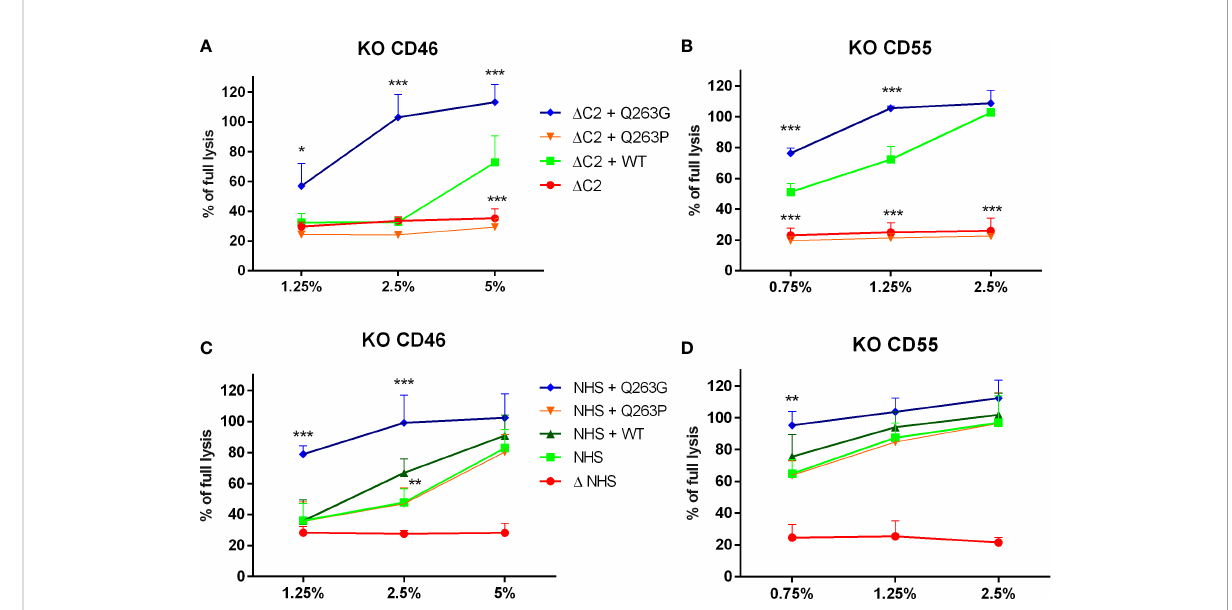
FIGURE 3 The impact of membrane-bound complement inhibitors CD46 and CD55 on CDC exerted by serum supplemented with C2 variants. CD46- knockout (A, C) and CD55-knockout (B, D) Ramos cells were loaded with calcein-AM, sensitized with rituximab and incubated with C2-depleted serum ( D C2, graphs (A, B) ) or normal human serum (NHS, graphs (C, D) supplemented with puri fi ed, recombinant C2 variants. The fl uorescence readout of released calcein was calculated as percentage of full lysis of cells achieved by incubation with 30% DMSO. Symbols *, **,and *** denote statistical signi fi cance at p levels <0.05, <0.01, and <0.001, respectively, according to Holm-Sidak ’ s multiple comparison